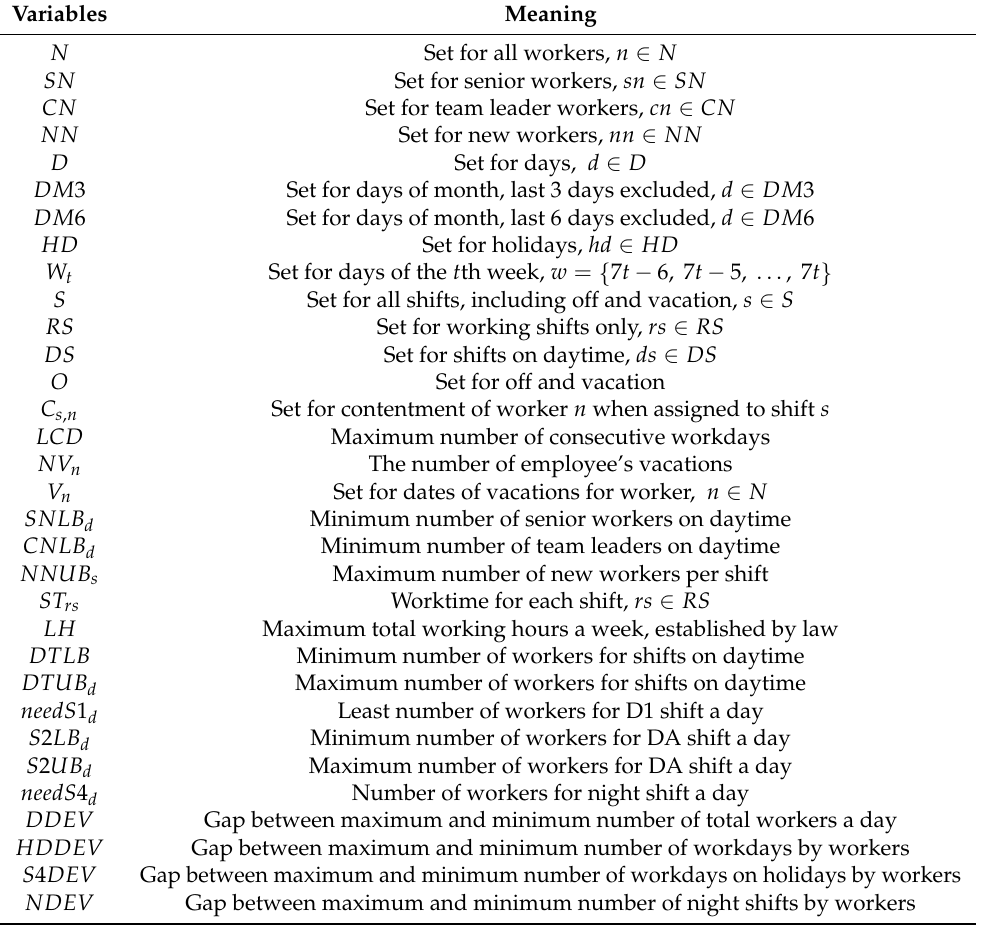
Table 1. Known parameters.